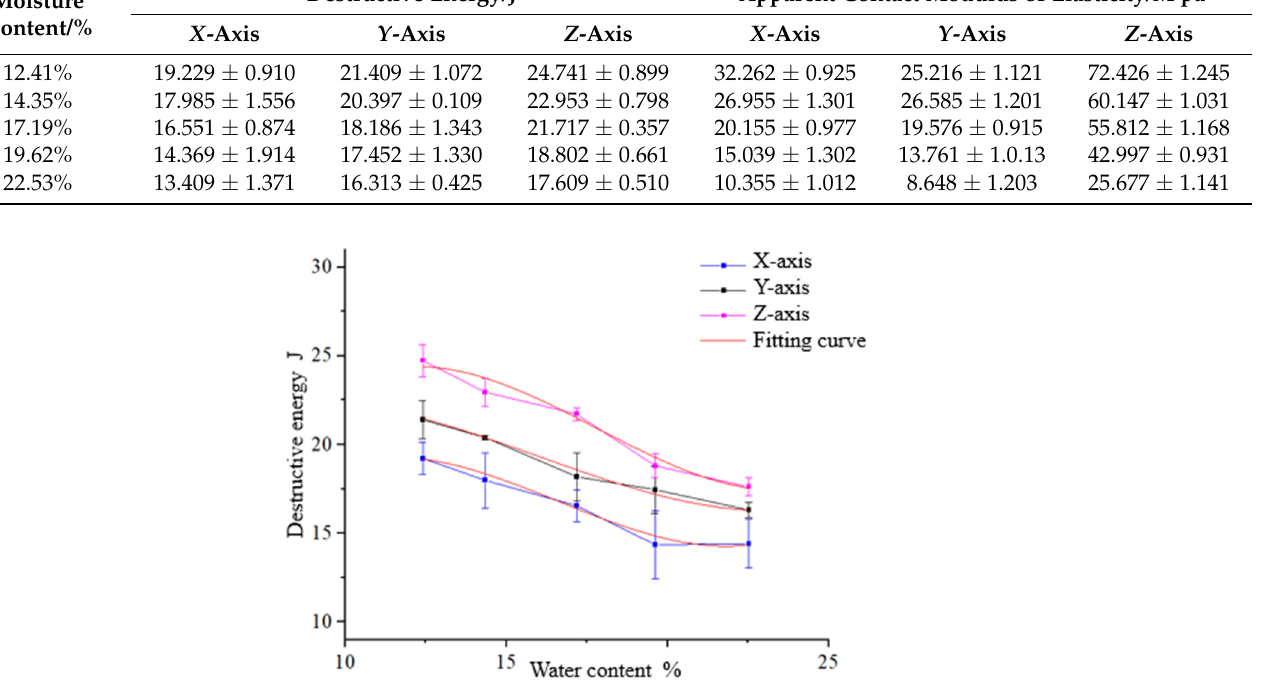
Figure 9. Triaxial damage energy of sorghum seeds.